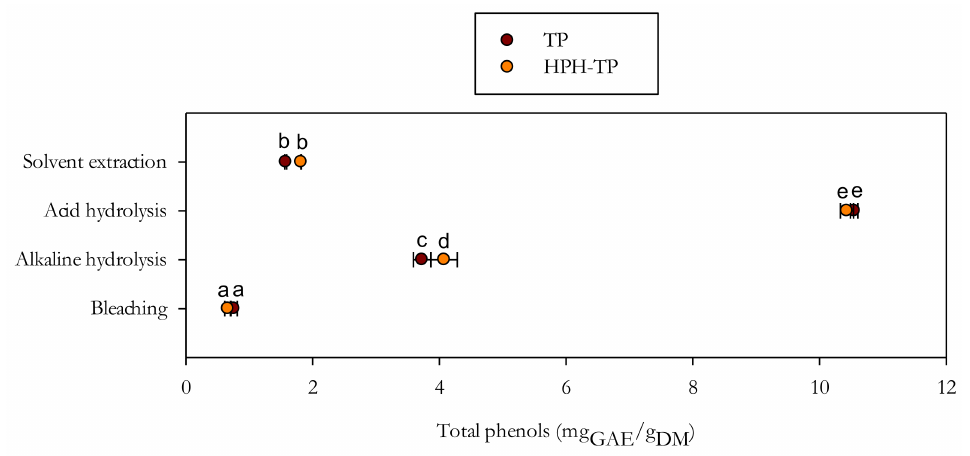
Figure 4. Comparison of total phenols content in liquors after the different stages of chemical hydrolysis, in comparison with conventional solid/liquid extraction with acetone (80% v / v in water). Different letters denote statistically significant ( p < 0.05)